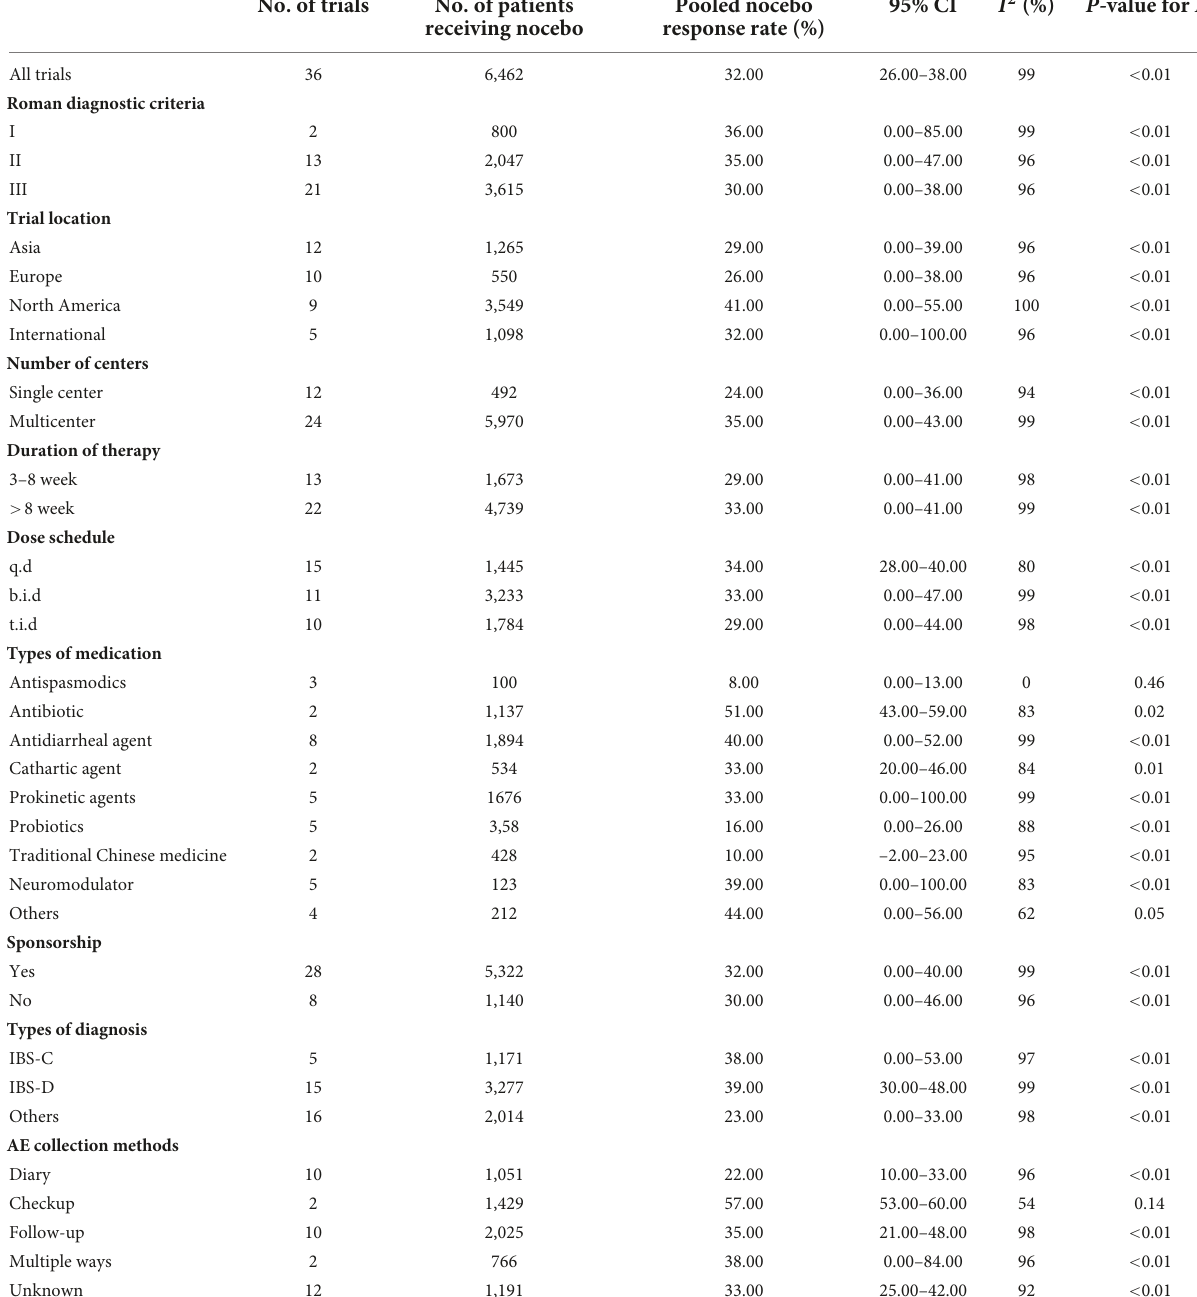
TABLE 2 Effect of trial characteristics on magnitude of the nocebo